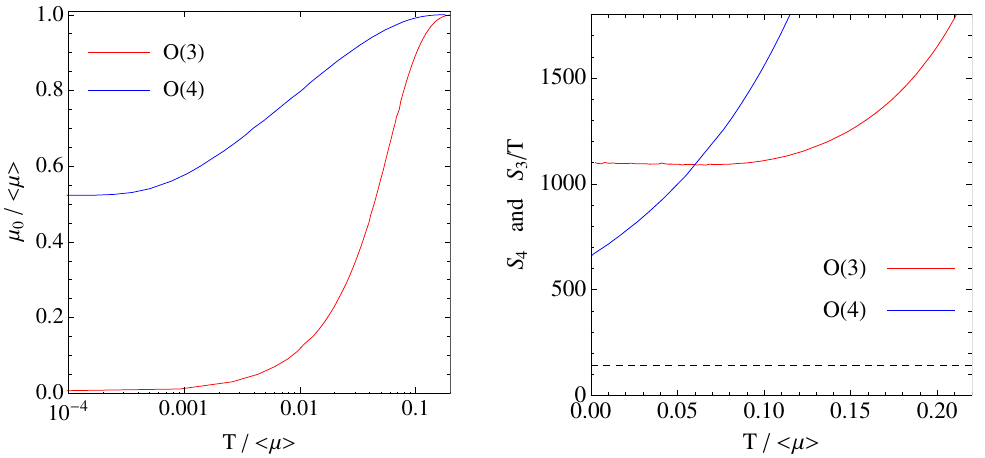
Figure 4 . (cid:22) 0 (left panel) and S 4 and S 3 =T (right panel) as a function of the temperature in the benchmark scenario A 1 where the back-reaction is small. Dimensional quantities are in units of h (cid:22) i with values quoted in table